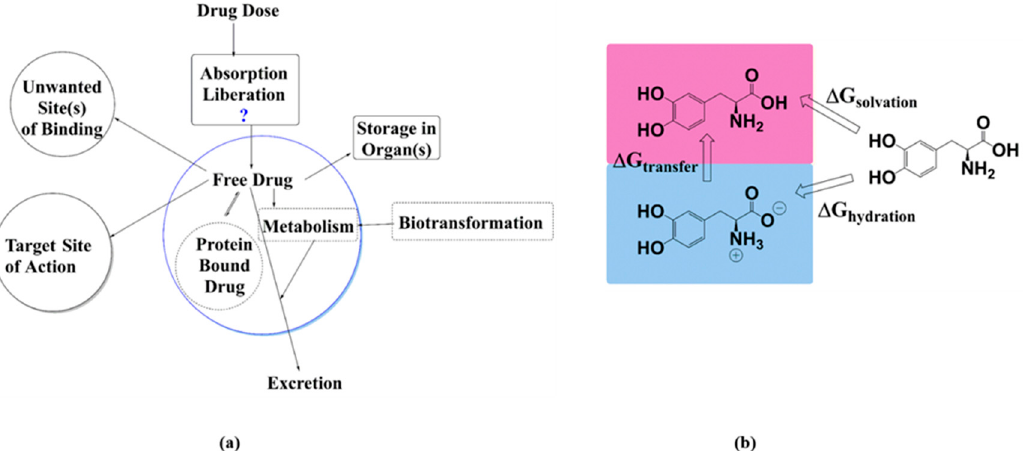
Figure 1. ( a ) Possible fates of a drug molecule inside human body; ( b ) the physical process of distribution of a drug molecule between two phases.